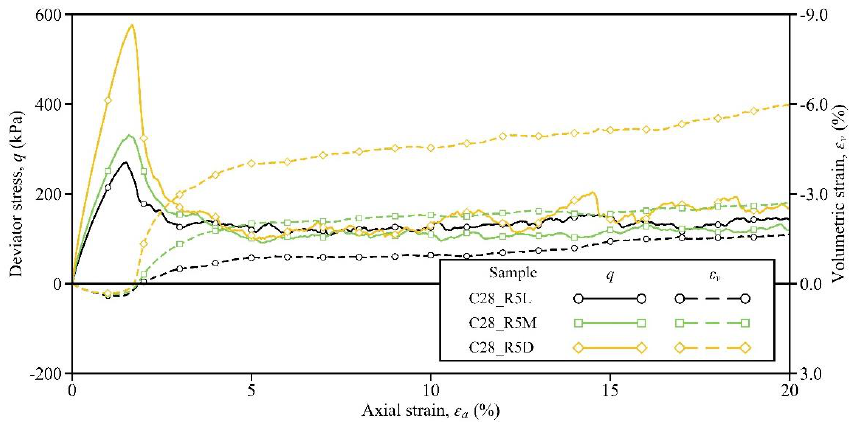
Figure 7. Influence of the initial void ratio on the stress – strain response.